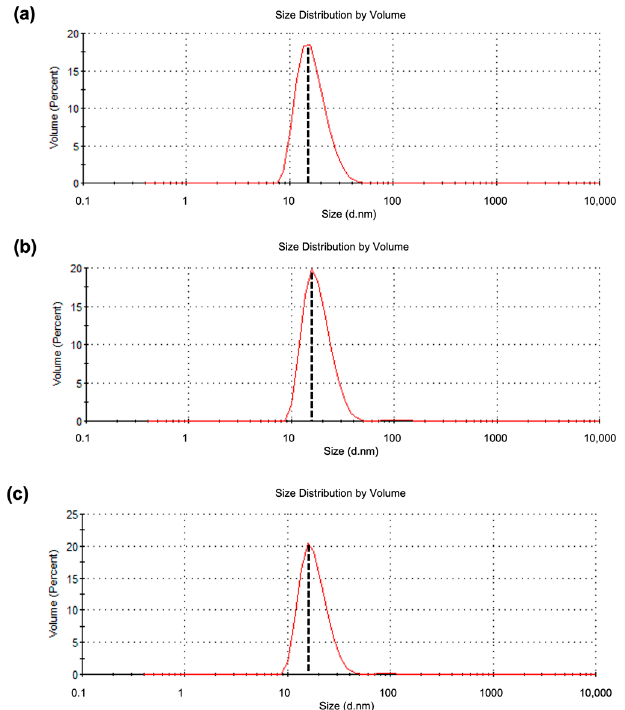
Figure 3. Dynamic light scattering analysis of the purified recombinant proteins. ( a ) C Δ 116- Mr NV-CP, ( b ) C Δ 116- Mr NV-CP harboring the β -SARS-CoV-2 RBD (C Δ 116- Mr NV-CP β -RBD ), and ( c ) C Δ 116- Mr NV-CP harboring the δ -SARS-CoV-2 RBD (C Δ 116- Mr NV-CP δ -RBD ). The vertical dotted lines intersecting the peaks represent the average diameter of VLPs derived from the C Δ 116- Mr NV-CP, C Δ 116- Mr NV-CP β -RBD , and C Δ 116- Mr NV-CP δ -RBD with hydrodynamic diameters of 16.99, 18.40, and 18.39 nm, respectively.